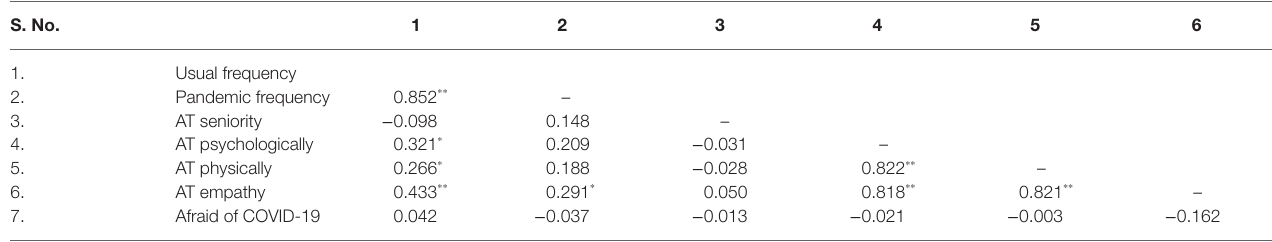
TABLE 3 | Spearman’s correlation coefficient between AT variables and outcomes. S. No.